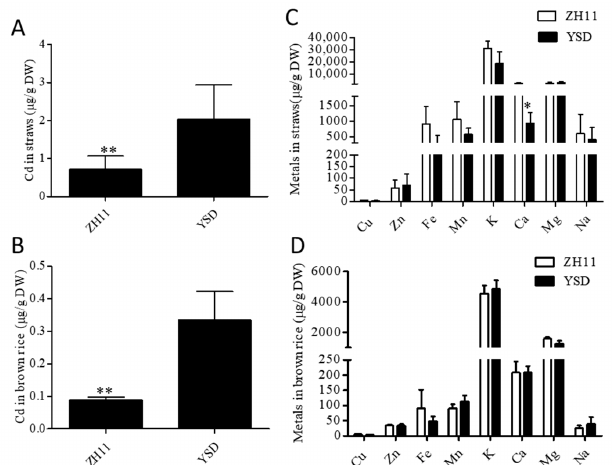
Figure 1. Cd content in YSD straw and grain was significantly higher than that in ZH11. Determi- nation of Cd and other metal elements in YSD and ZH11 straw ( A , C ) and brown rice ( B , D ) at ripening stage grow in 0.4 mg/kg Cd-contaminated field. Data are presented as the means (±SD), n = 5. Significant differences were determined using the Student’s t -test: * p < 0.05, ** p < 0.01.